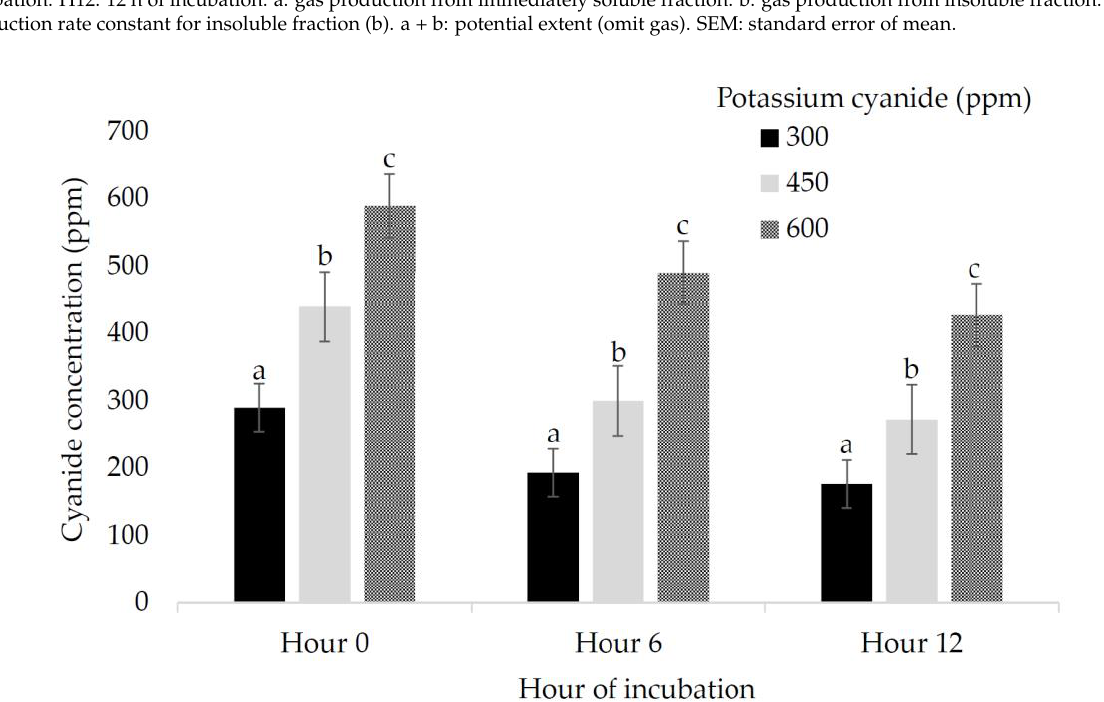
Table 2. Addition of rhodanese enzymes and potassium cyanide (KCN) levels on gas kinetics, cumulative gas at 96 h after incubation and ruminal cyanide concentration.